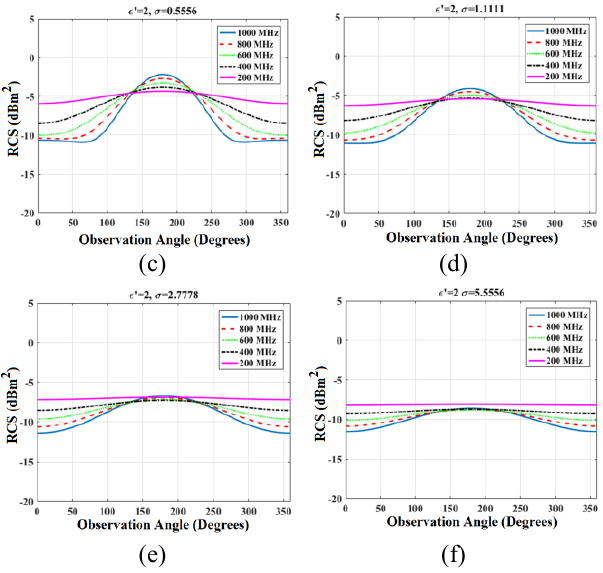
Figure 12: Wideband RCS results of scatterer while 𝜎 changes. (a) 𝜎 =0.0556, (b) 𝜎 =0.2778, (c) 𝜎 =0.5556, (d) 𝜎 =1.1111, (e) 𝜎 =2.7778, (f) 𝜎 =5.5556. To demonstrate that the flattening is related to the dimensions, the RCS plots for the largest 𝜎 value are recalculated for bigger structures. Curvatures start to show again as radius increases as in Figure 13